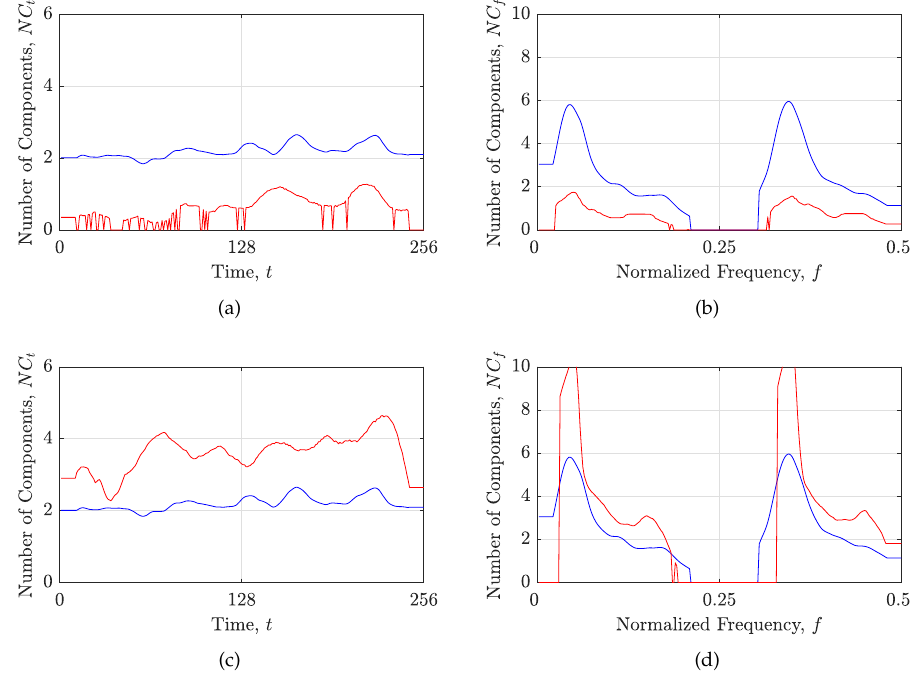
Figure 4. The local number of components in the starting (blue line) and the reconstructed (red line) TFD based on the RTwIST algorithm for the signal z SS , with α = 0.84, β = 0.69 and: ( a , b ) p = 0.75, δ t = 0.99, δ f = 0.99, Γ = 0.25, Υ = 1; ( c , d ) p = 0.1, δ t = 0.75, δ f = 0.75, Γ = 0.1, Υ =